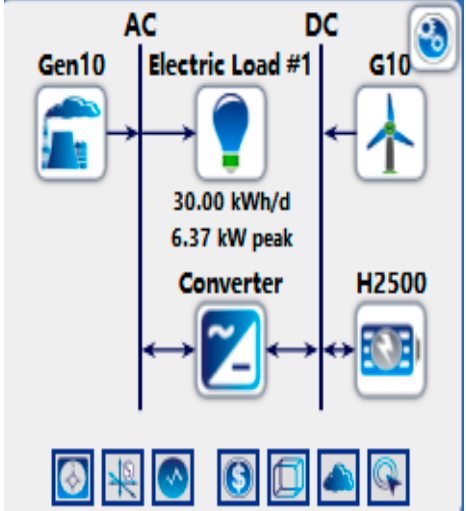
Figure 4. Physical configuration of a microgrid system in HOMER.